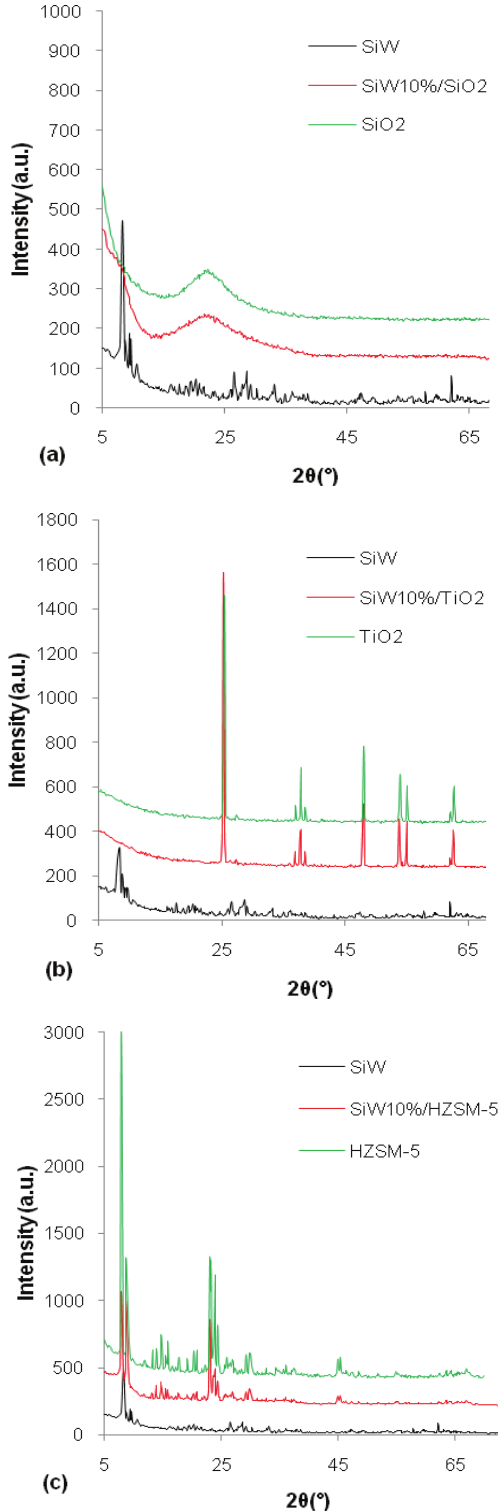
Figure 4. PXRD patterns for: (a) SiW, SiW10%/SiO